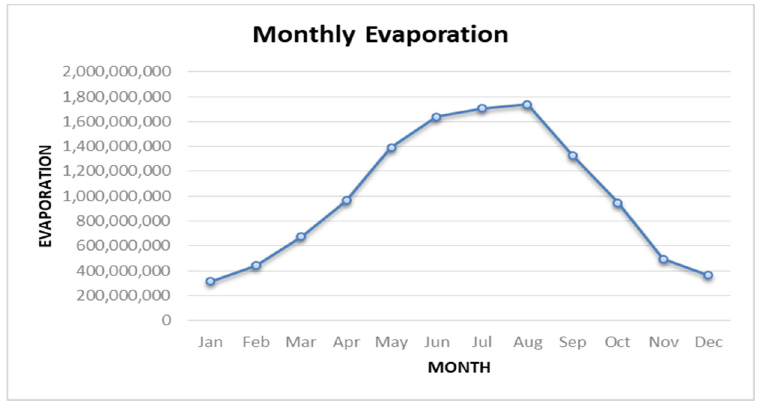
Figure 6. Average monthly evaporation (m 3 /month) from 2009 to 2020. Table 4. Monthly average evaporation (BCM/month) at Lake Nasser during the period from 2009